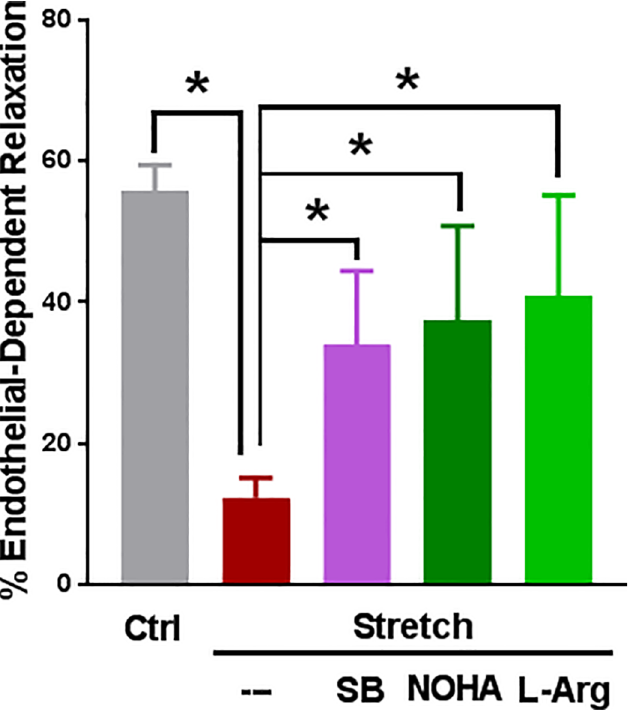
Fig 8. Stretch injury of RA decreasedendothelial function that was restoredwith SB 203580. RA was unstretched(Ctrl), longitudinally stretched to twice its length (Stretch), or longitudinally stretched and treated with SB 203580(SB, 20 μ M), NOHA (50 μ M) or L-Arginine (L-Arg, 2 mM) and endothelial relaxationwas determined as describedin Fig.1. n = 7 different rats, * p < 0.05, (paired t-test).